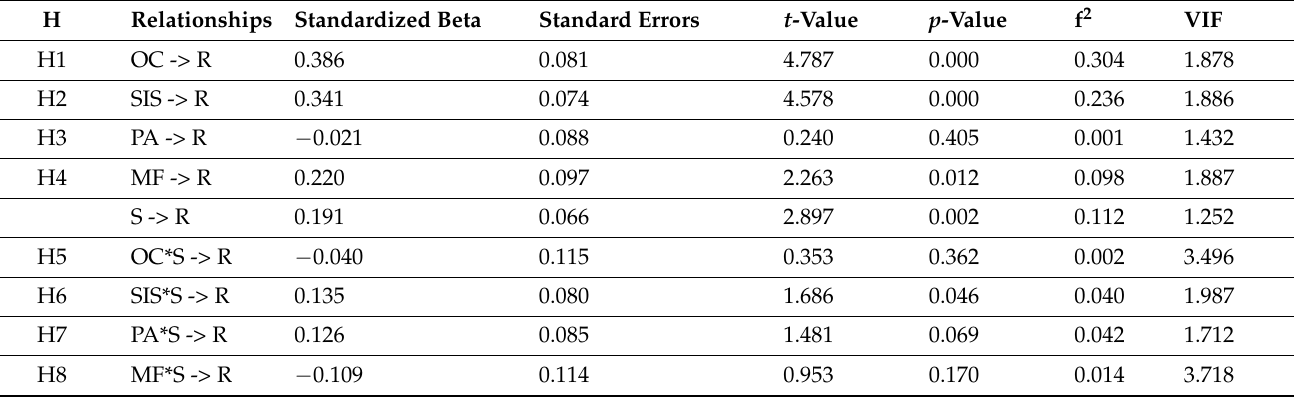
Table 13. Assessment of the structural model.